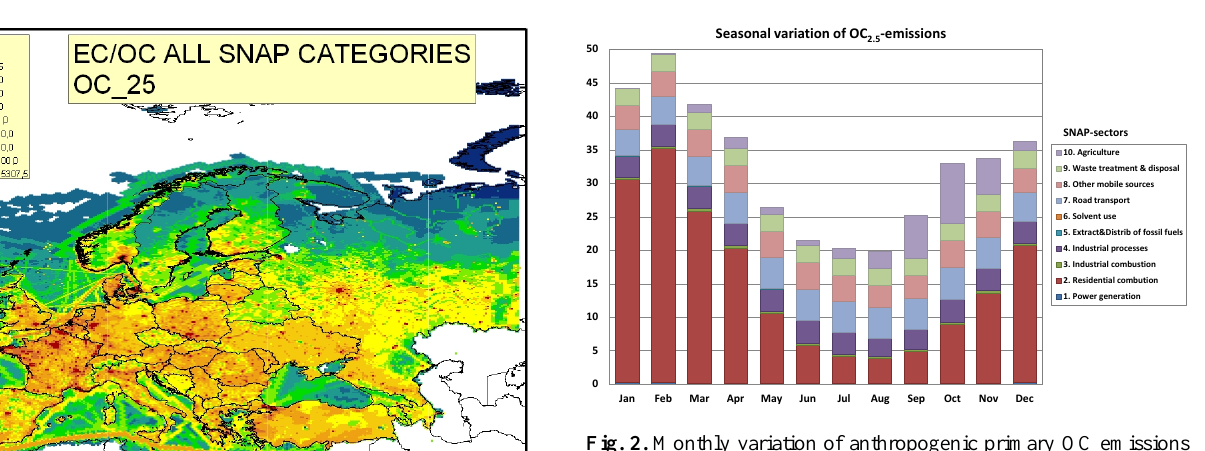
Fig. 2. Monthly variation of anthropogenic primary OC emissions ( < 2.5µm) in 17 European countries (EU15+Norway and Switzer- land), specified by source-sector. Unit: ktonnes(C)month − 1